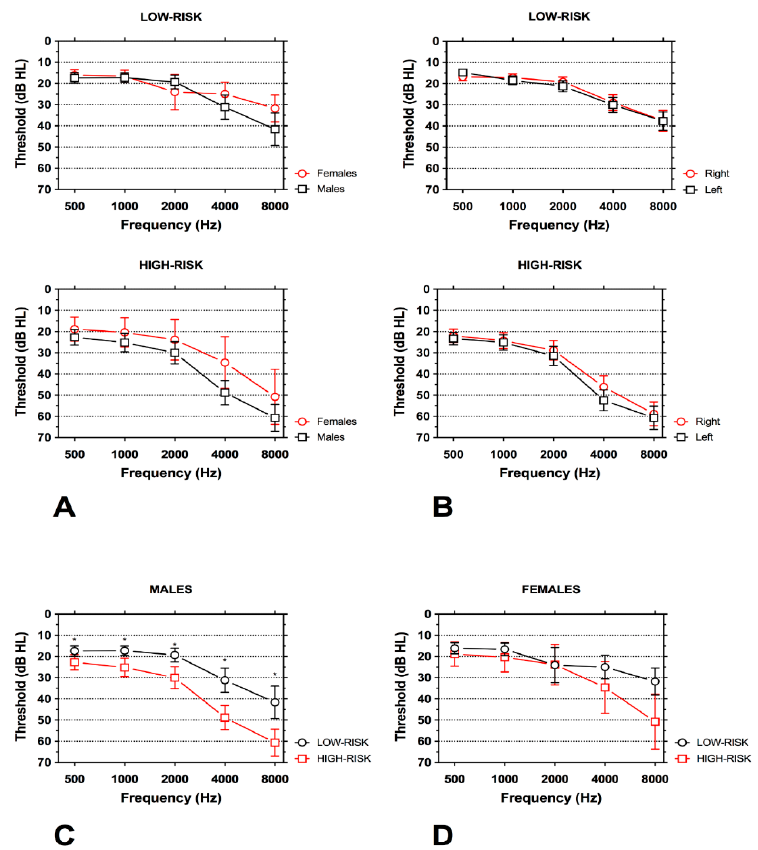
Figure 2. Pure tone audiogram (PTA) in the LOW-RISK and HIGH-RISK groups showing differences between males and females and side. Means ± 95 CI are shown. ( A ) Worse hearing thresholds were found in males; however, the difference within the same group was not significant ( p = 0.086). ( B ) No significant differences were found in hearing threshold between the right and the left ear although thresholds for high frequencies in the left ear were worse compared to the right ear ( p = 0.64). ( C ) PTA for males; individuals in the HIGH-RISK group had a significantly worse hearing threshold than individuals in the LOW-RISK group ( p < 0.001). ( D ) PTA for females; although worse hearing for high frequencies was found in patients in the HIGH-RISK group, the difference was not statistically significant ( p = 0.12).